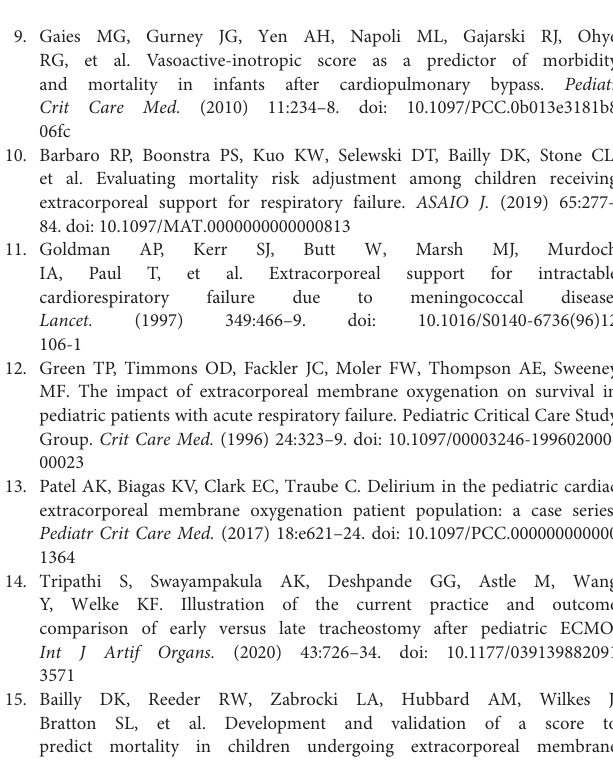
Supplemental Figure 1A | Receiver operating characteristic (ROC) curve and Logistic regression for PIM2 predicting mortality for Patients receiving Venovenous ECMO. Supplemental Figure 1B | Receiver operating characteristic (ROC) curve and Logistic regression for PRISM III predicting mortality for Patients receiving Venovenous ECMO. Supplemental Figure 1C | Receiver operating characteristic (ROC) curve and Logistic regression for PELOD predicting mortality for Patients receiving Venovenous ECMO. Supplemental Figure 2A | Receiver operating characteristic (ROC) curve and Logistic regression for PIM 2 predicting mortality for Patients receiving Venoarterial ECMO. Supplemental Figure 2B | Receiver operating characteristic (ROC) curve and Logistic regression for PRISM III predicting mortality for Patients receiving Venoarterial ECMO. Supplemental Figure 2C | Receiver operating characteristic (ROC) curve and Logistic regression for PELOD predicting mortality for Patients receiving Venoarterial ECMO. Supplemental Figure 3A | Receiver operating characteristic (ROC) curve and Logistic regression for PIM2 predicting mortality for Patients receiving early ECMO. Supplemental Figure 3B | Receiver operating characteristic (ROC) curve and Logistic regression for PRISM III predicting mortality for Patients receiving early ECMO. Supplemental Figure 3C | Receiver operating characteristic (ROC) curve and Logistic regression for PELOD predicting mortality for Patients receiving early